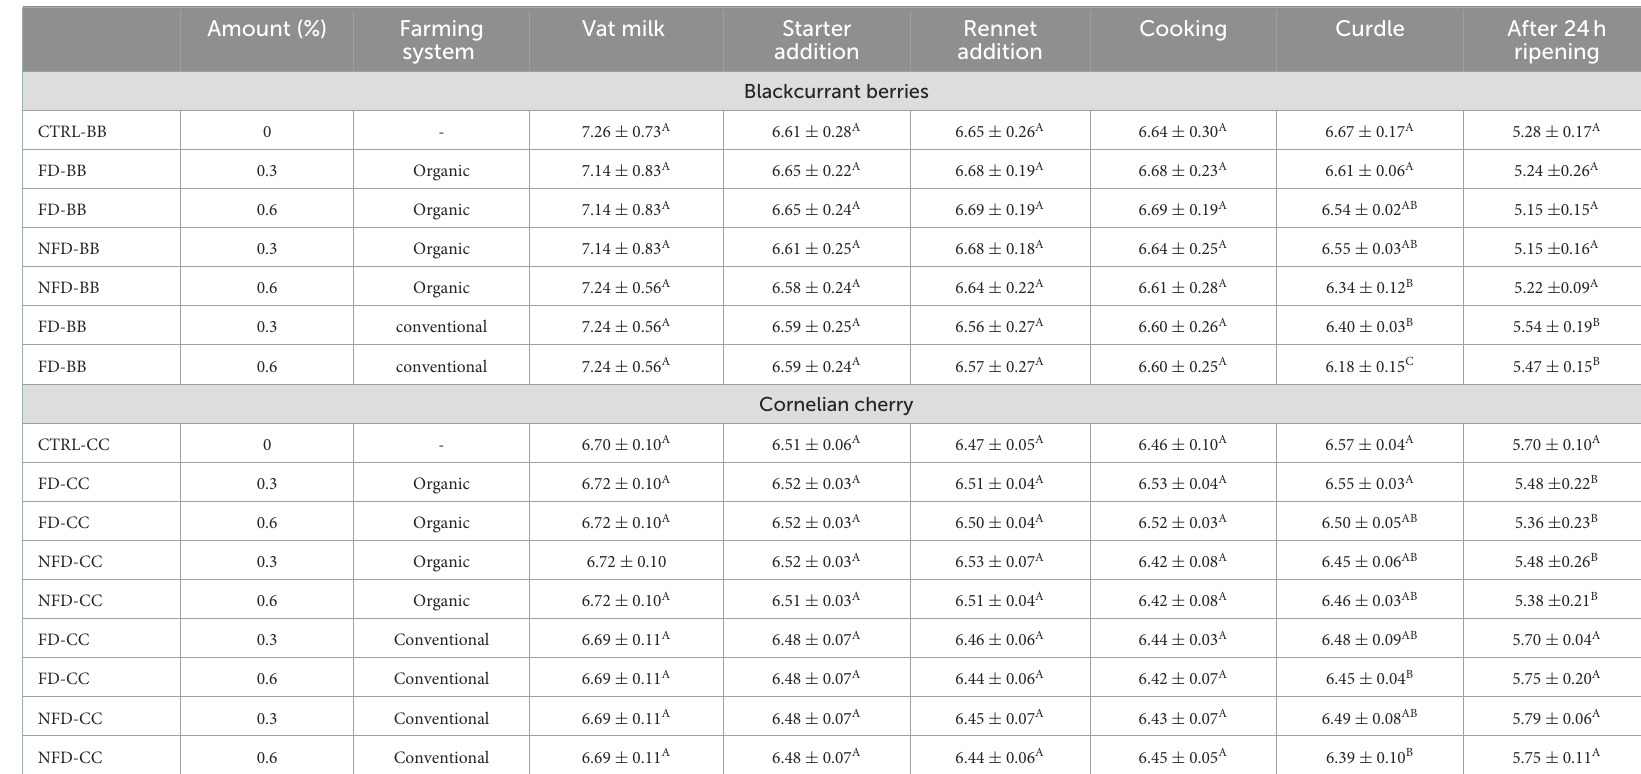
TABLE 1 pH during model cheese